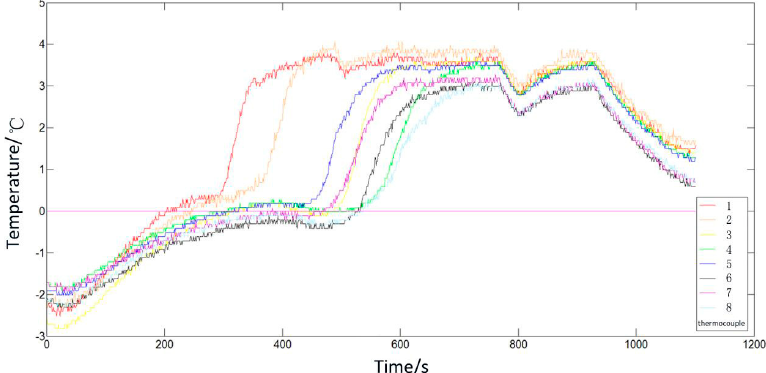
Figure 9. Temperature variation of the evaporating tube wall during the deicing period.